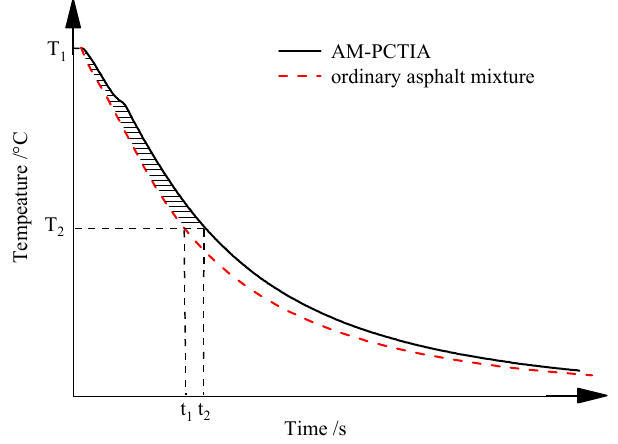
Figure 8. Cooling processes of the two samples.